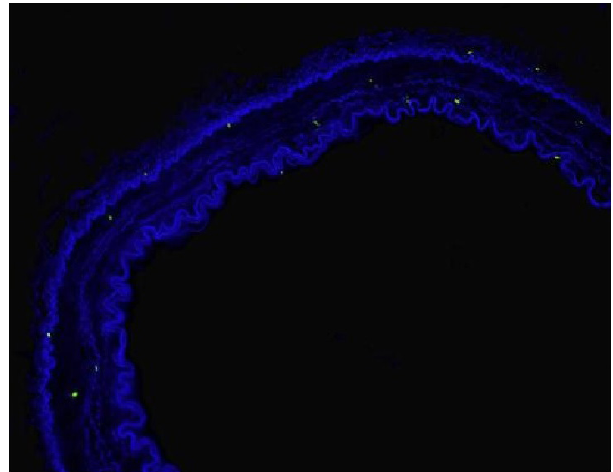
Fig. 2A – Fluorescein microscopy of slides processed with the terminal deoxynucleotidyl transferase-mediated dUTP-biotin nick end labeling (TUNEL) method in the isotonic solution group (Group S).